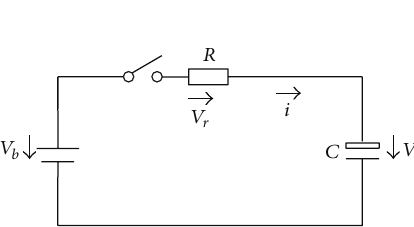
Figure 4: The precharge model.